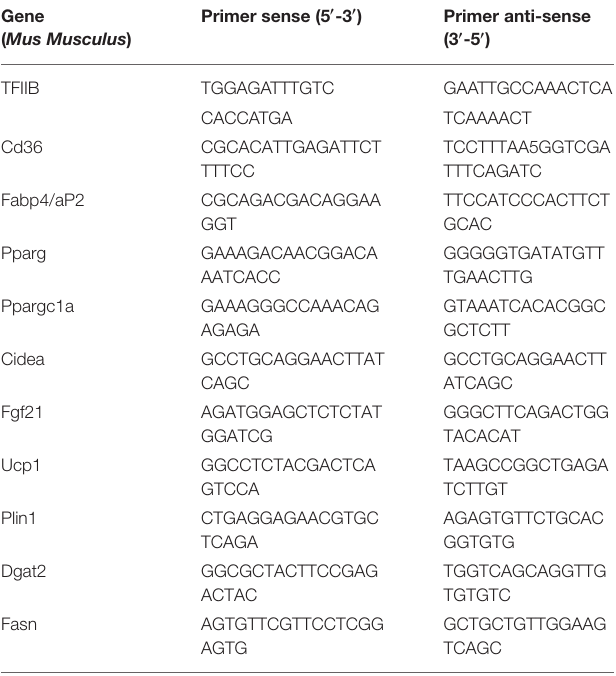
TABLE 1 | Nucleotide sequences of primers used for RT-qPCR amplification. Gene ( Mus Musculus